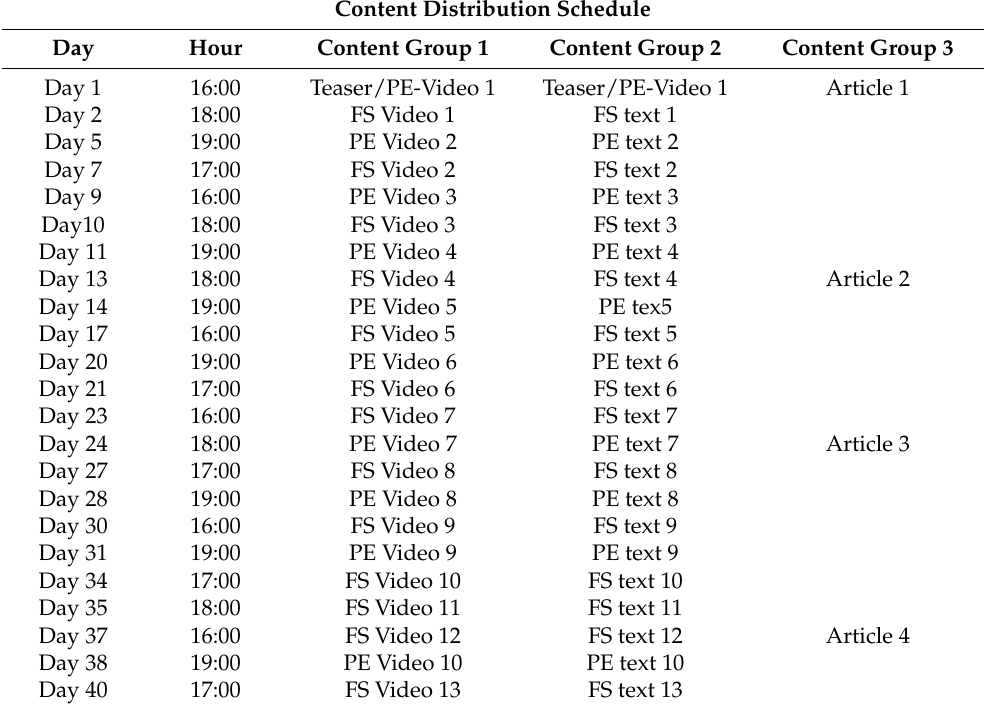
Table A2. Timetable and contents sent to each